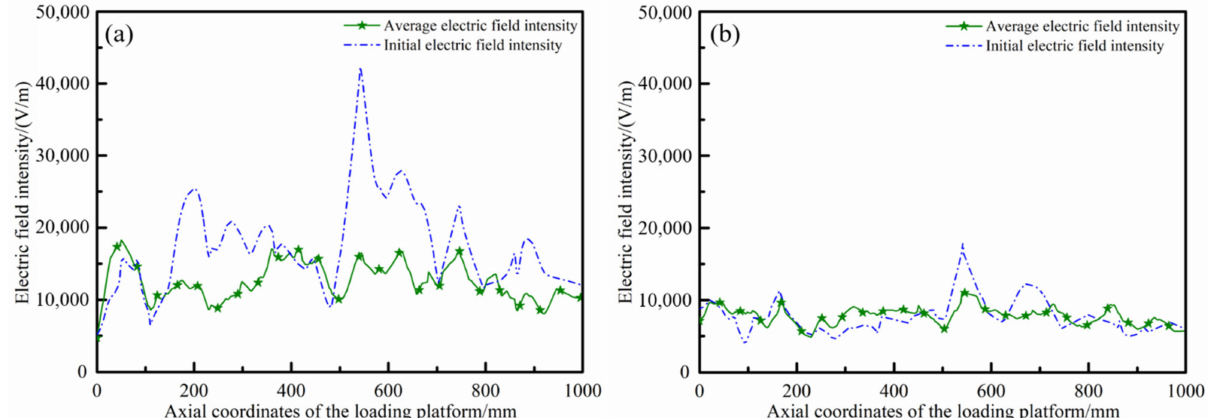
Figure 12. Electric field curves before and after the introduction of the mode stirrers under two types of working conditions: ( a ) number (6); ( b ) number (23).